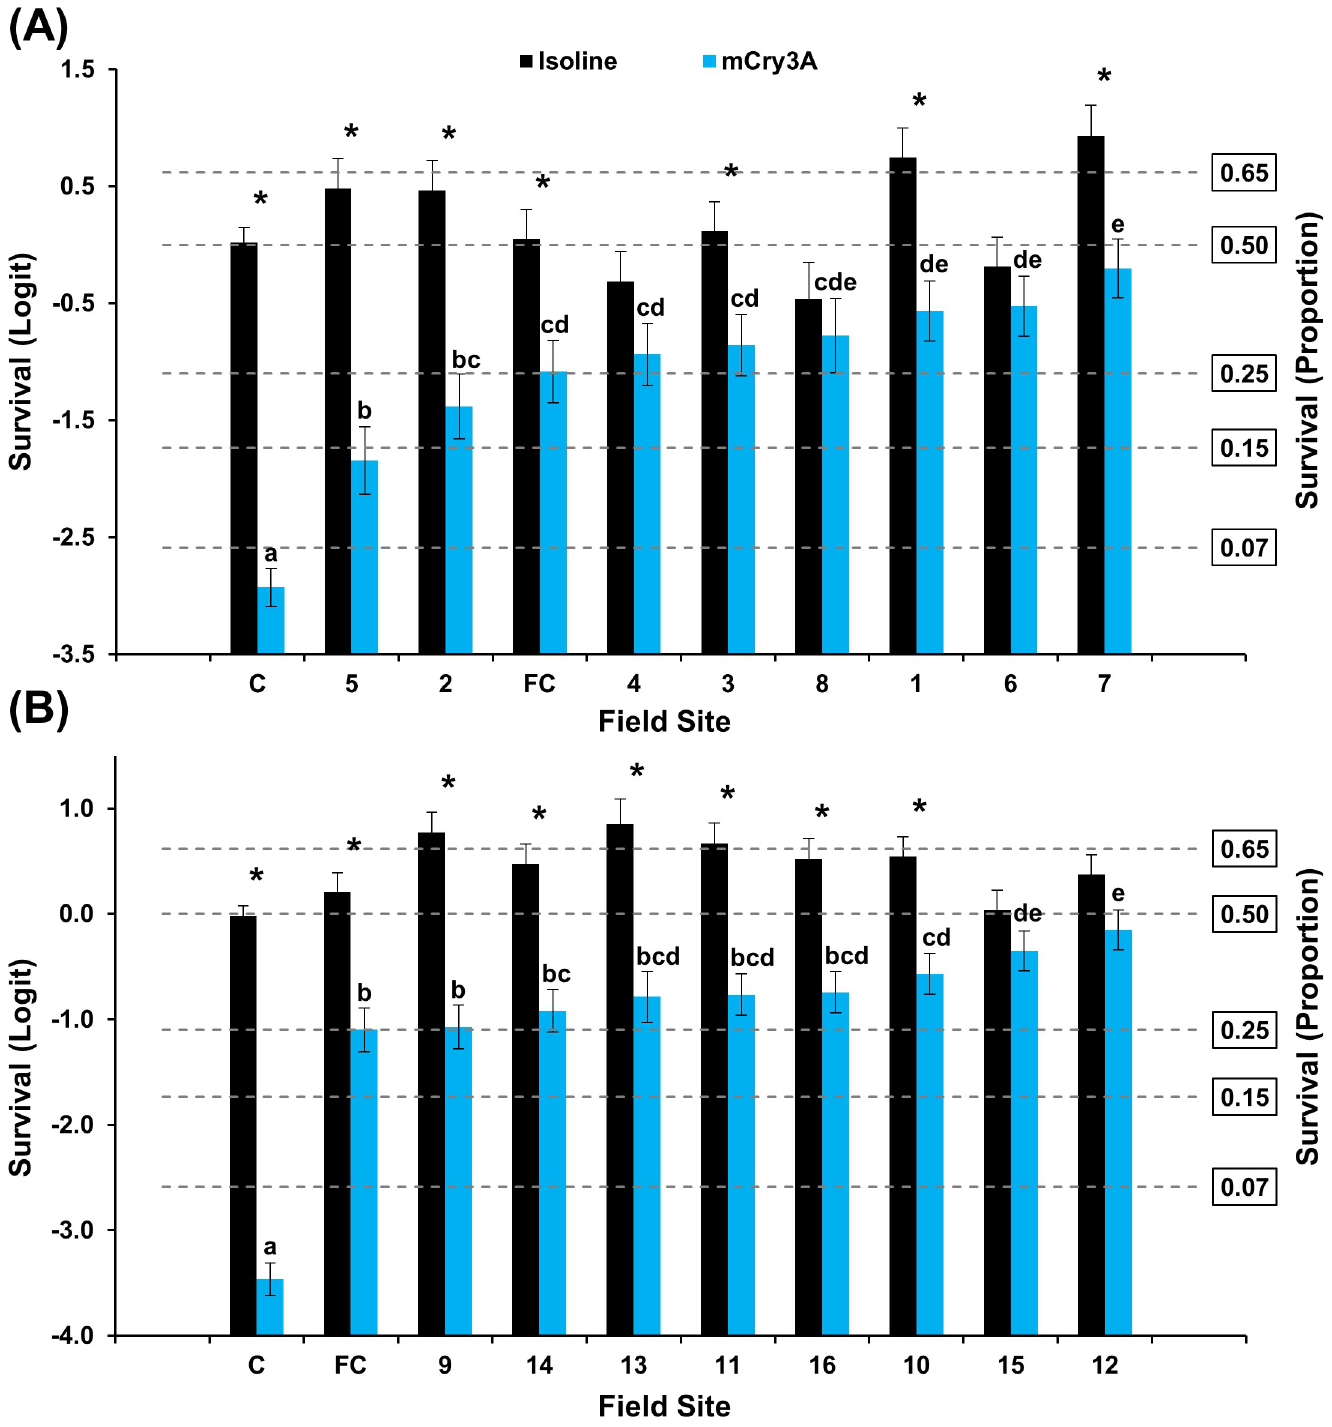
Fig 5. Mean WCR larval survival ( ± SE) of Buffalo County populations on mCry3A and its isoline. ((A) 2016 bioassays. (B) 2017 bioassays. C = composite laboratory control; FC = field control. � indicates significantly higher survival on isoline compared to mCry3A. Within years, mCry3A means with the same letter were not significantly different (generalized linear model, P > 0.05; LSMEANS